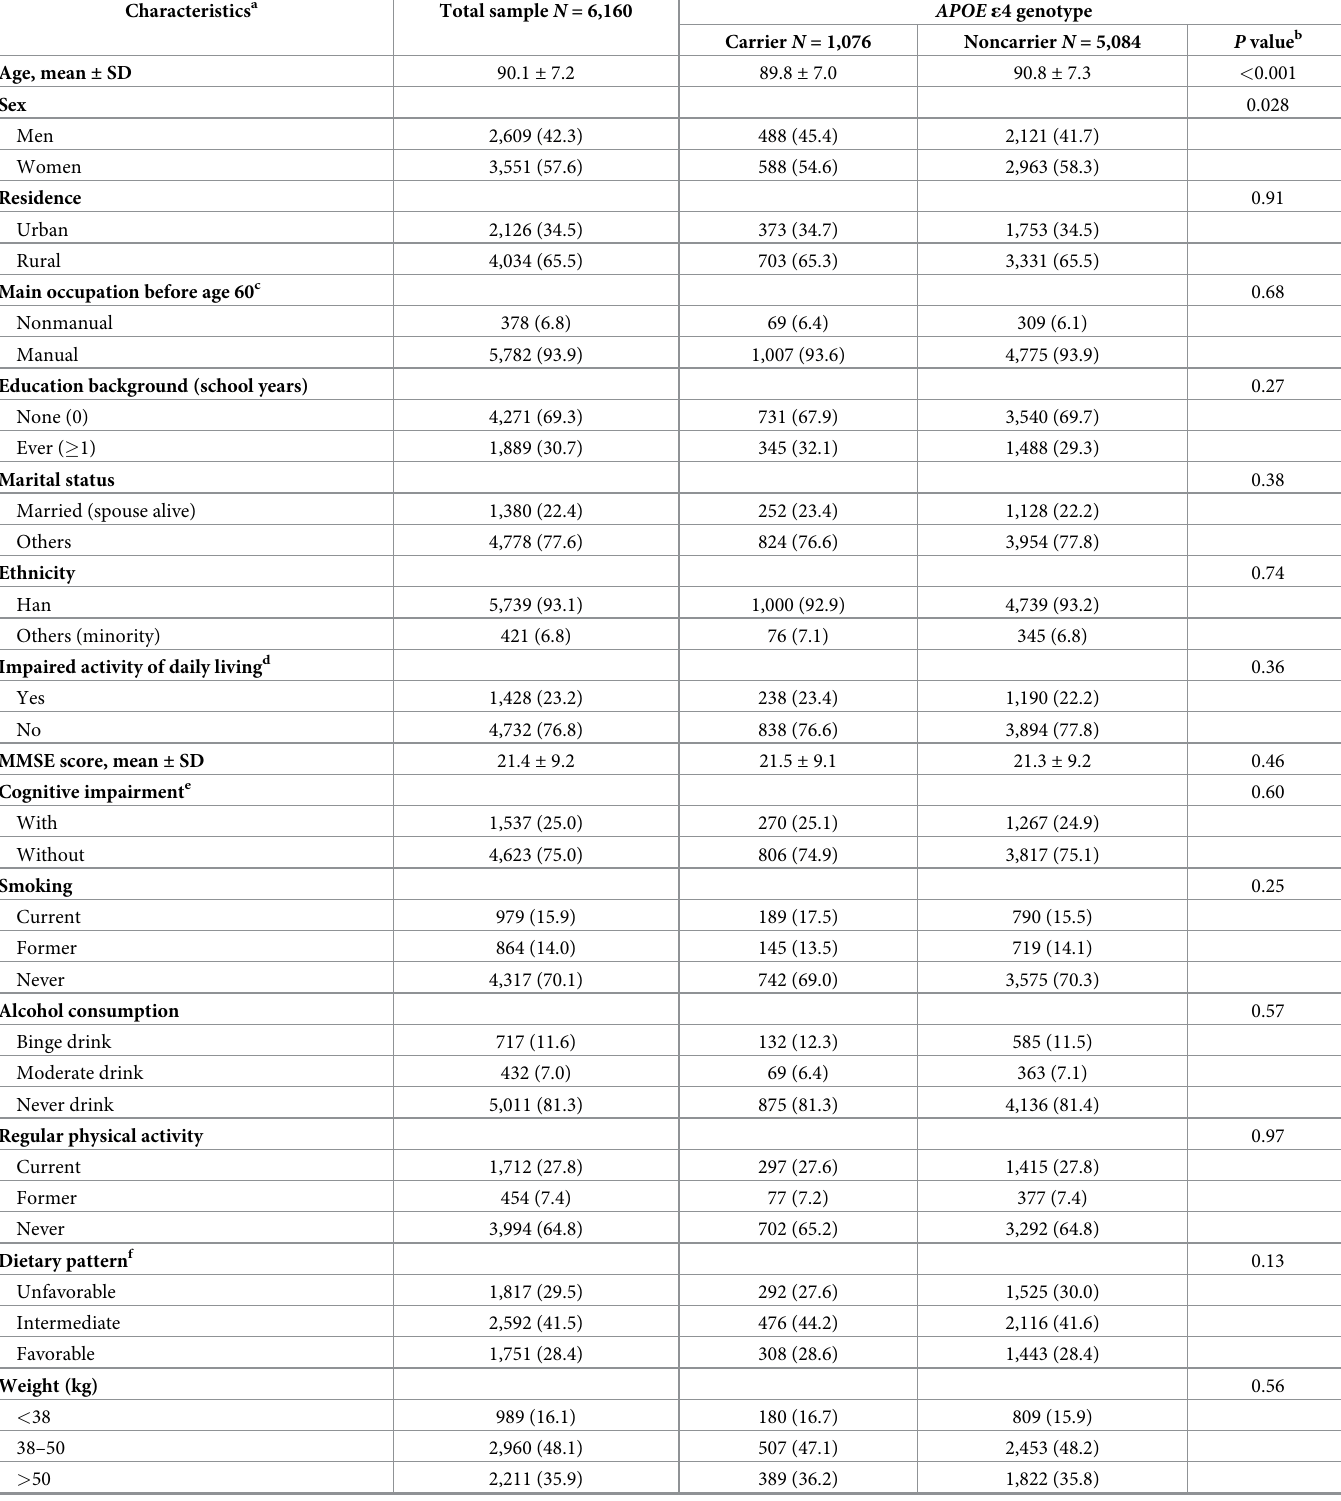
Table 1. Baseline characteristics of the 6,160 participants by APOE ε 4